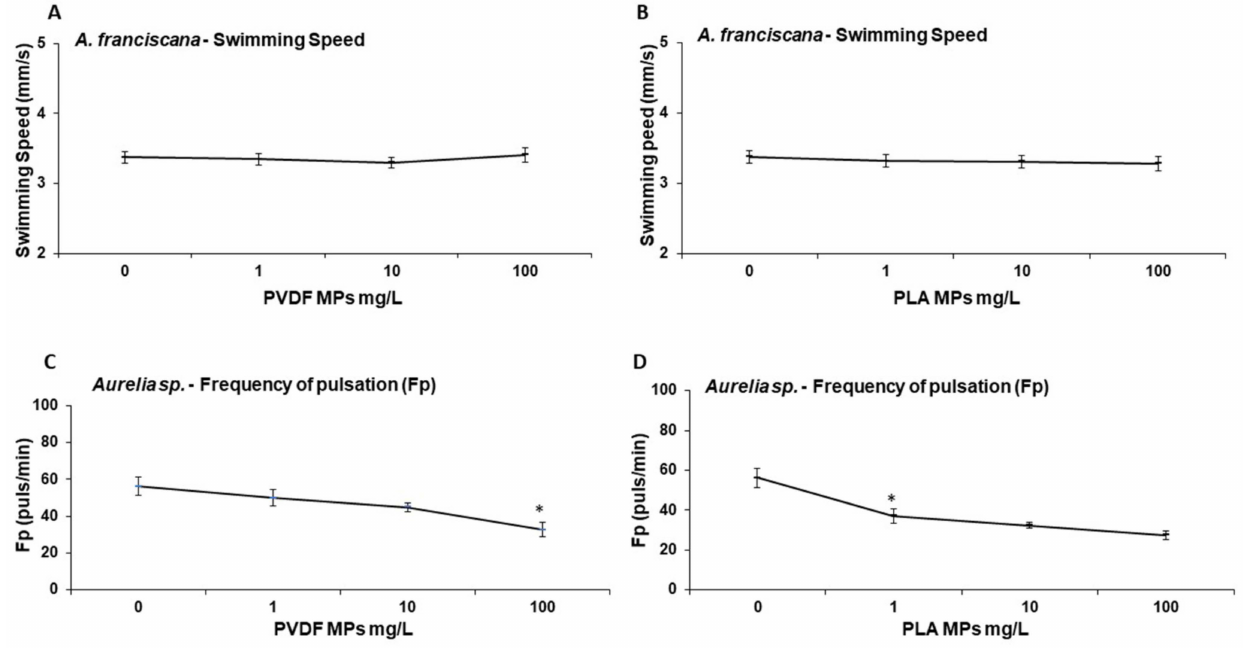
Figure 6. Behavioral responses of A. franciscana nauplii ( A , B ) and Aurelia sp. ephyrae ( C , D ) exposed to PVDF and PLA MPs (0, 1, 10, 100 mg/L) for 24 h. Swimming speed (mm/s) of A. franciscana after exposure to PVDF ( A ) and PLA ( B ) MPs. Frequency of pulsation of Aurelia sp. ephyrae after exposure to PVDF ( C ) and PLA ( D ). * p <